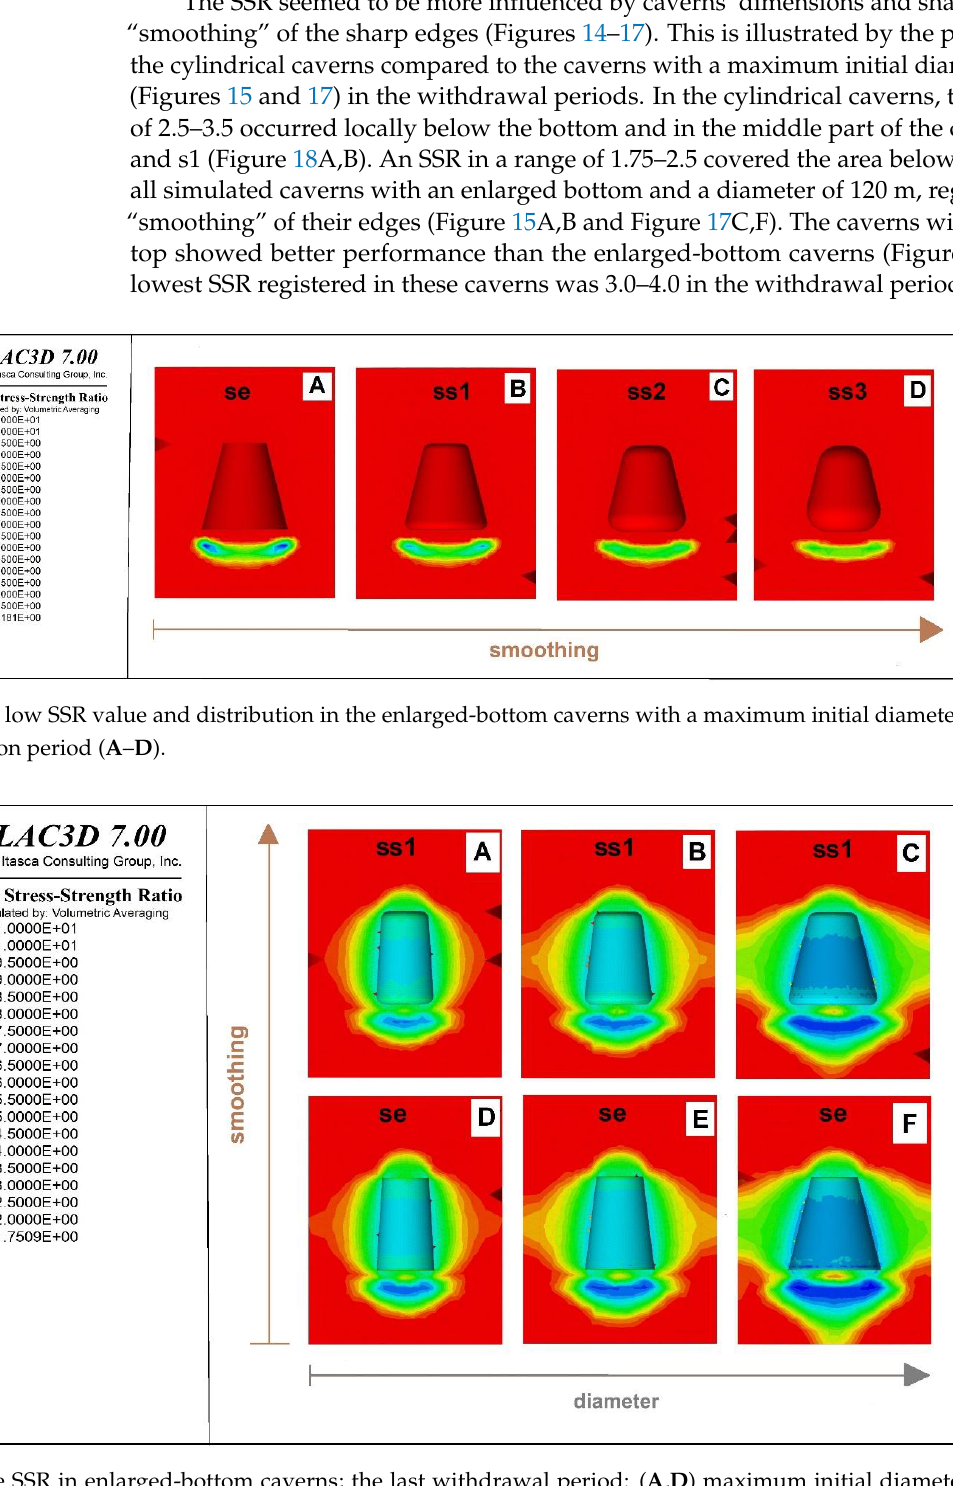
Figure 15. The SSR value and distribution in the enlarged caverns; the first withdrawal period: ( A – H ) maximum initial diameter of 120 m, ( I , J ) maximum initial diameter of 90 m, ( K , L ) maximum initial diameter of 75 m.